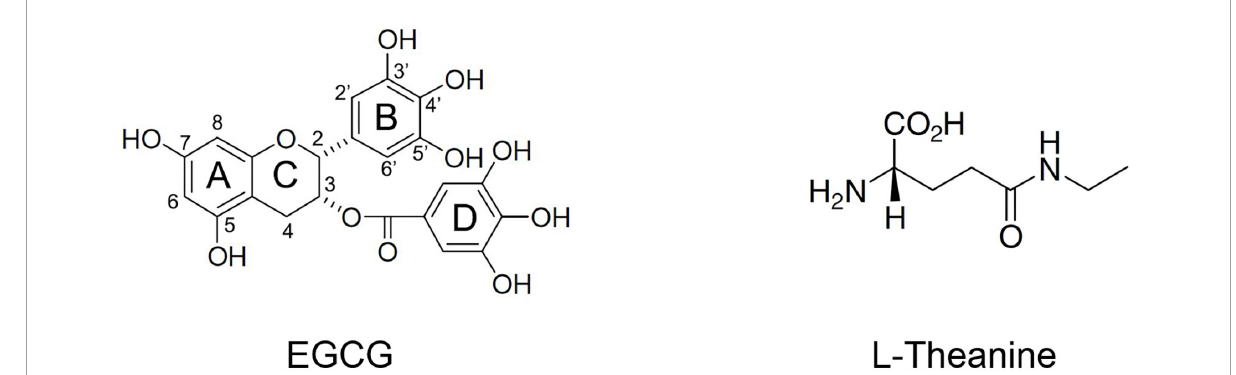
FIGURE1 Molecular structures of the active ingredients Epigallocatechin gallate (EGCG) and N -ethyl- L -glutamine ( L -theanine) in tea.